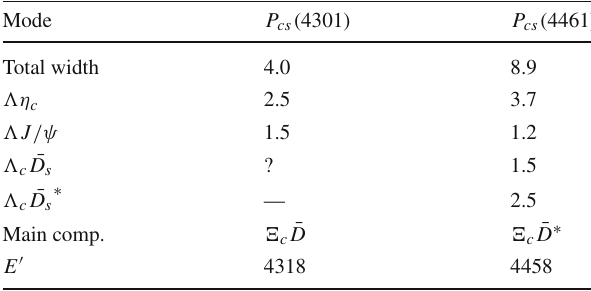
− system (unit: MeV) 2